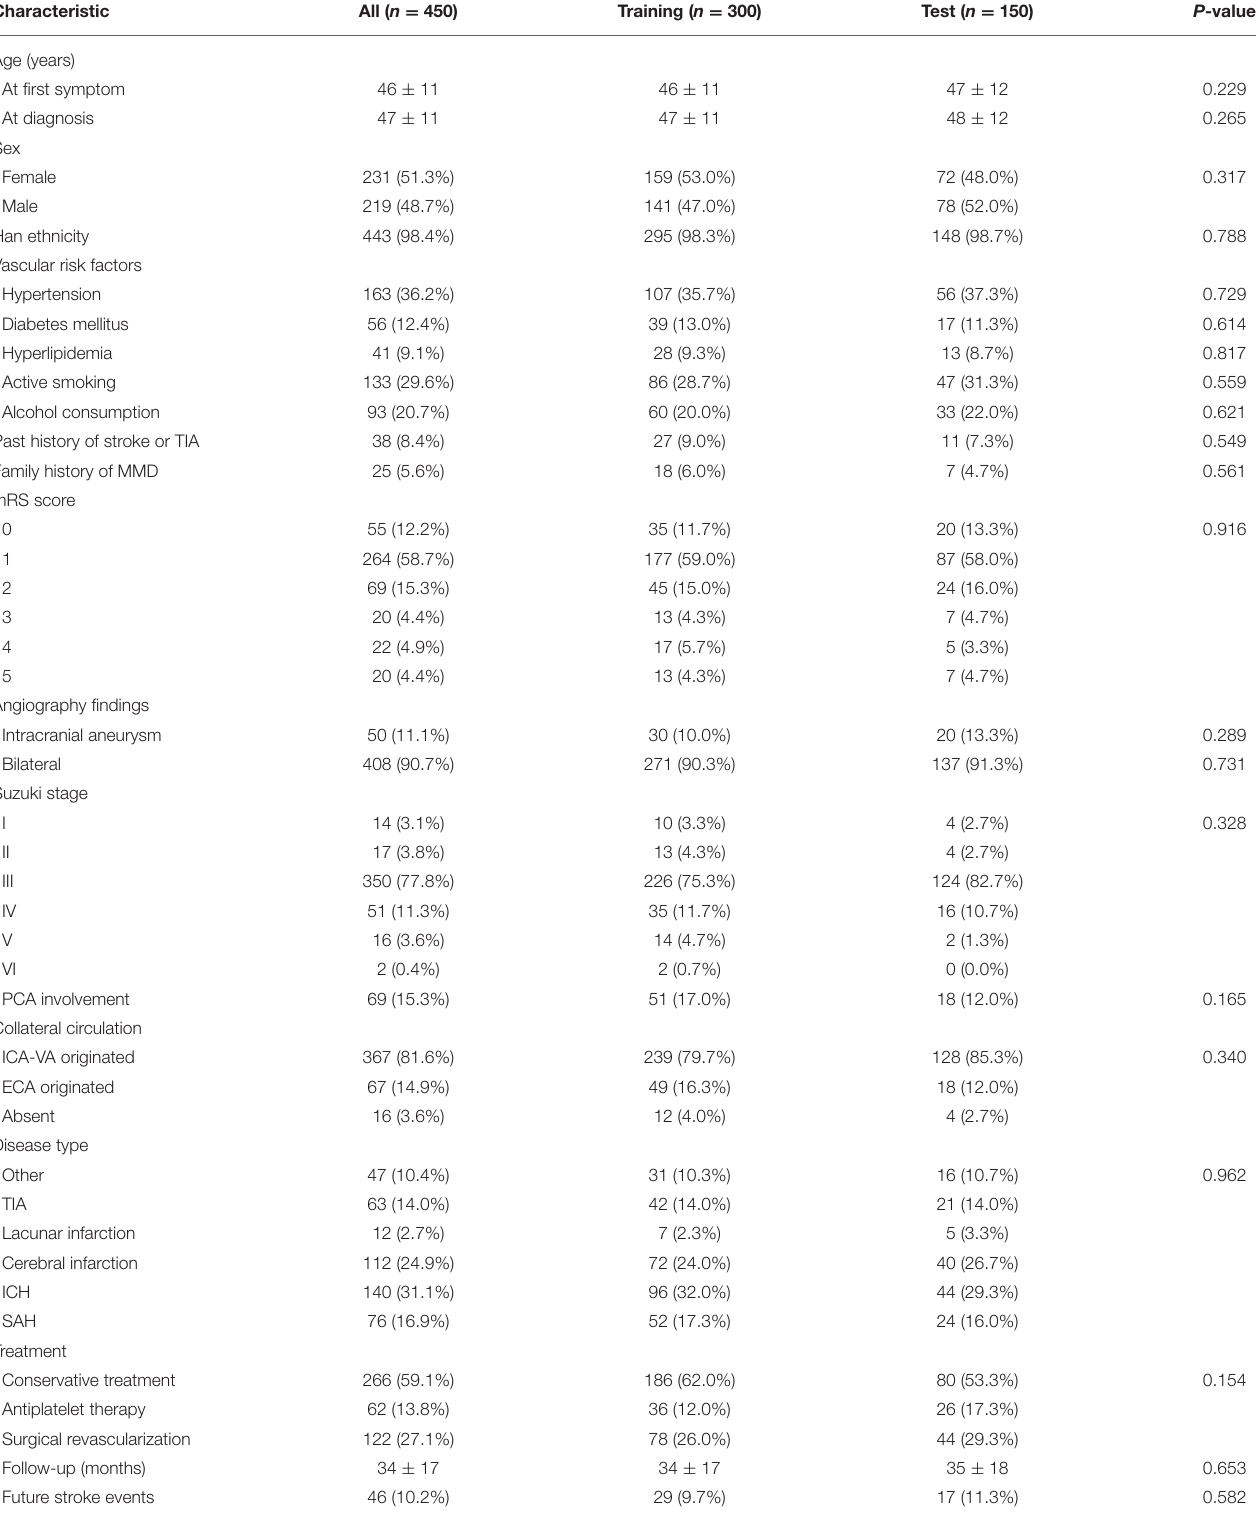
TABLE 1 | The clinical characteristics of adult patients with moyamoya disease.